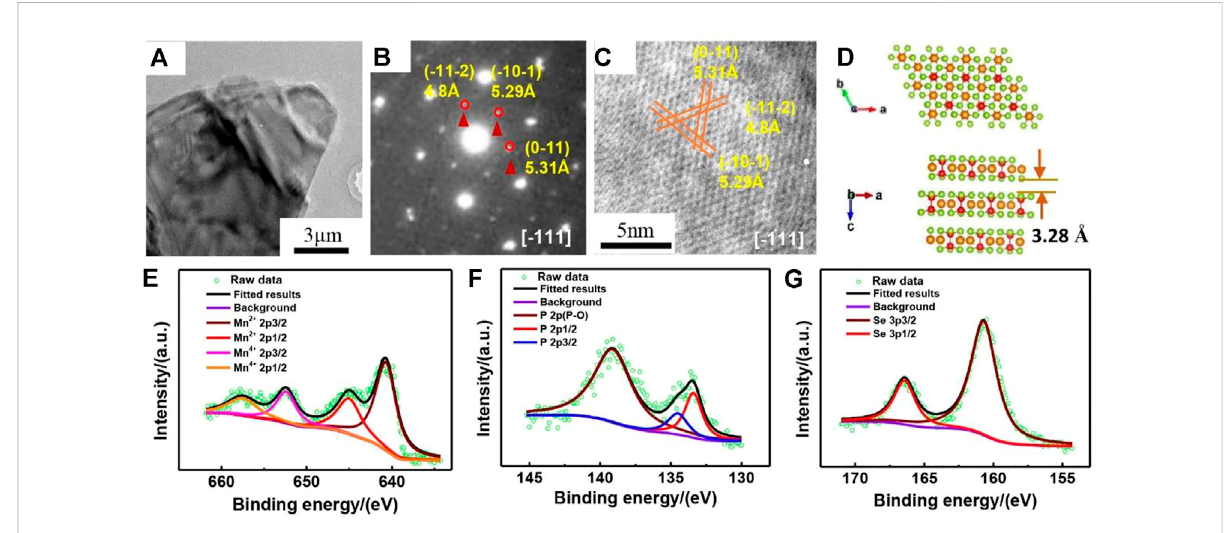
FIGURE 1 The purity, structure, and composition of MnPSe 3 nano fl ake. (A) The typical TEM image of layered MnPSe 3 . (B) The selected area electron diffraction (SAED) pattern ofMnPSe 3 nano fl ake view from[-111]. (C) The high-resolutionTEM (HRTEM)imageofMnPSe 3 wasviewed along thesame direction corresponding to the SAED. (D) The crystal structure schematic of MnPSe 3 along the b and c axes, respectively. (E – G) The high-resolution XPS shows spectra of the Mn, P, and Se elements,